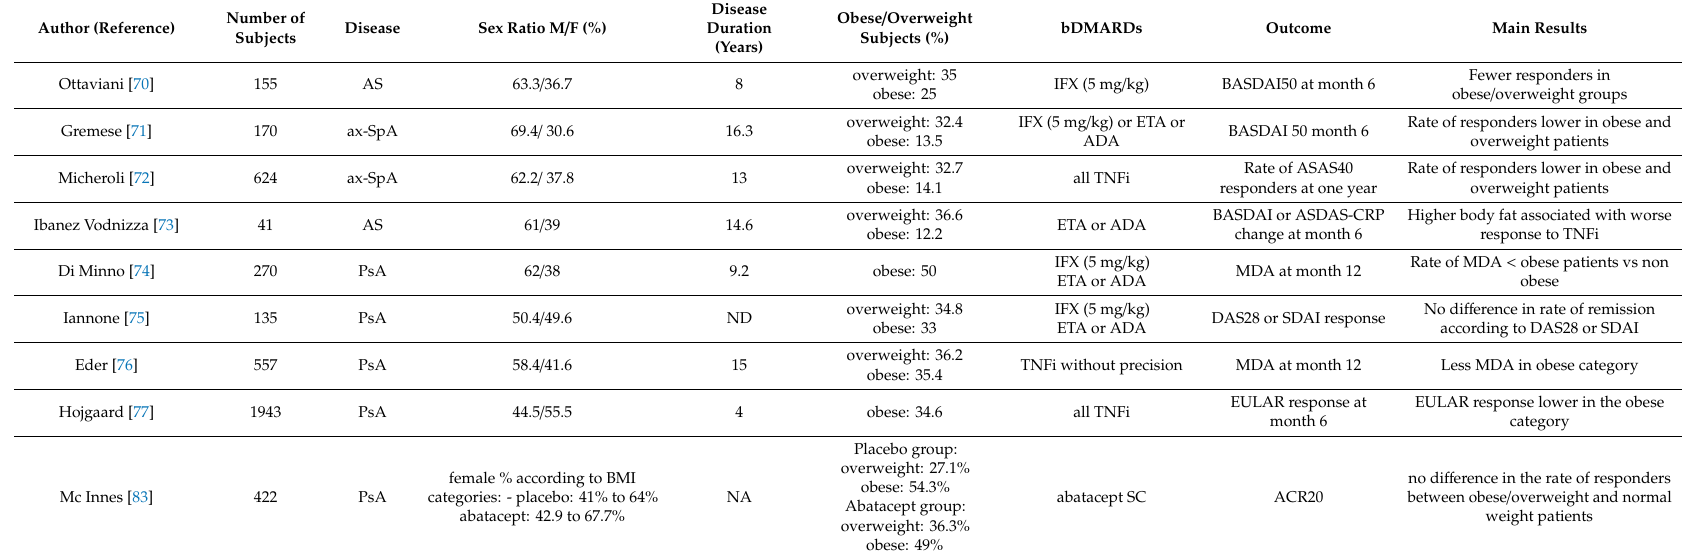
Table 4. Response to bDMARDs in obese / overweight patients with